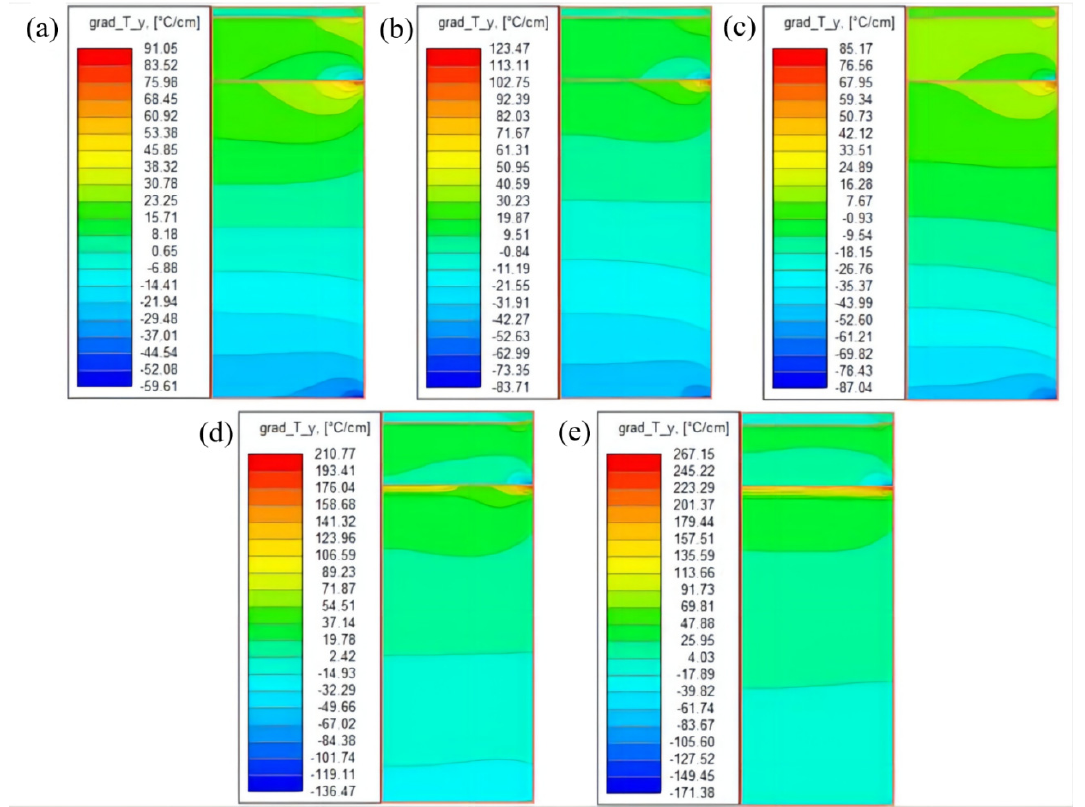
Figure 4. Effect of heating body position on axial temperature gradient; ( a ) 0 mm, ( b ) 15 mm, ( c ) 30 mm, ( d ) − 15 mm, and ( e ) − 30 mm. ( c ) 30 mm, ( d ) − 15 mm, and ( e ) − 30